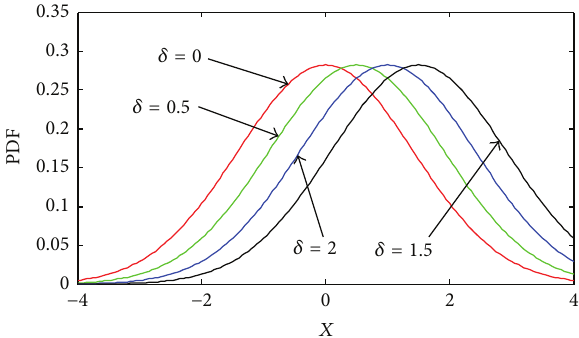
Figure 3: PDF of stable distribution with different 𝛿 values (𝛼 = 2, 𝛽 = 0, 𝛾 = 1) .